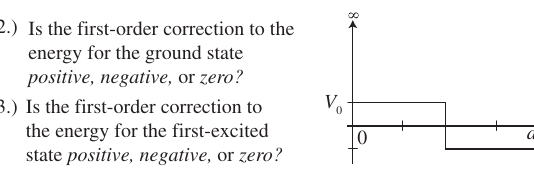
FIG. 3. Pretest questions on perturbations to infinite square wells of width a . In 2016, the pretest questions were given to students as multiple choice without the option to explain their reasoning, while in 2017 they were asked on paper with a prompt to explain their reasoning for each